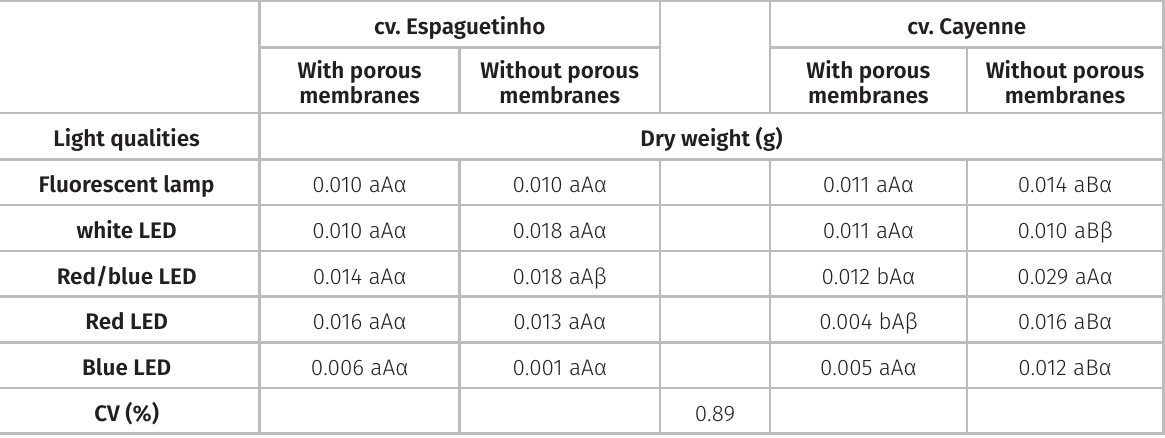
Table III. Dry weight of Capsicum frutescens cultivars (‘Espaguetinho’ and ‘Cayenne’) cultivated under different light qualities and types of